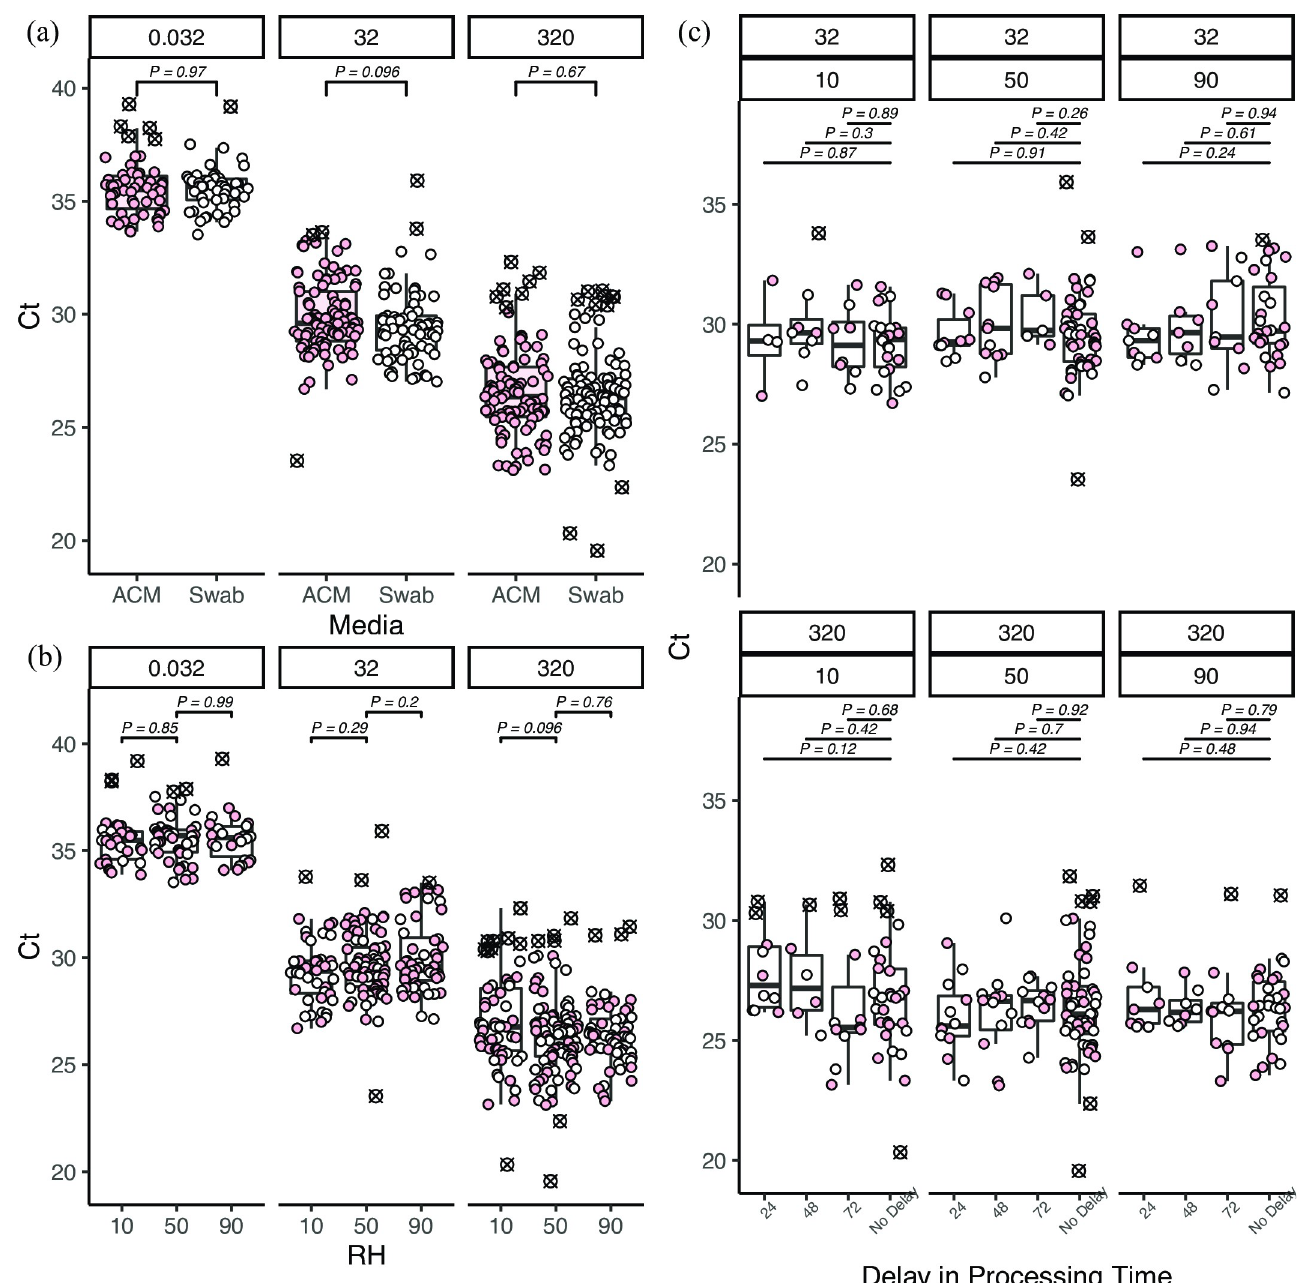
Fig 5. Bench series 3 results. Pink points represent samples collected from ACM and white points are samples collected from flocked swabs. Outliers are shown as crossed out circles (a) Measured Ct values at three main concentrations (0.032, 32, and 320 gc/L respectively) tested recovered from each capture media. (b) Measured Ct values at three measured aerosolized virus concentrations and RH levels. Outliers are shown as crossed out circles (c) Measured Ct values from samples processed immediately, with a 24-hour delay, with a 48-hour delay, and with a 72-hour delay. The top panel box is the aerosol concentration tested (32 gc/L or 320 gc/L) and the second panel box is the humidity at which the particles were aerosolized and at which the samples were maintained until being